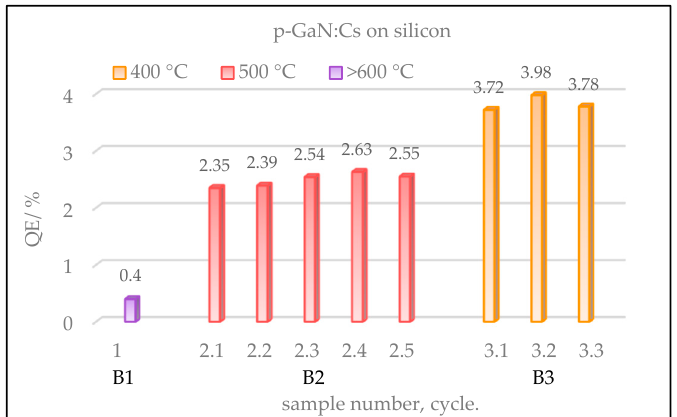
Figure 10. Gained QE values of p-GaN:Cs on silicon photocathodes, depending on various temperatures used in the thermal cleaning. Sample B1 (violet) was thermally cleaned above 600 °C and activated only once. Sample B3 (yellow), which was cleaned at 400 °C, achieved the best QE in three cycles. At the same time, sample B2 (red), which was thermally cleaned at 500 °C, showed relatively lower QE than B3, but a higher reproducibility in five cycles.